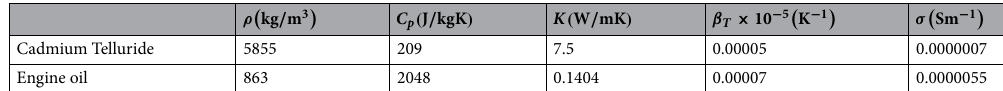
ρ (cid:31) kg / m 3